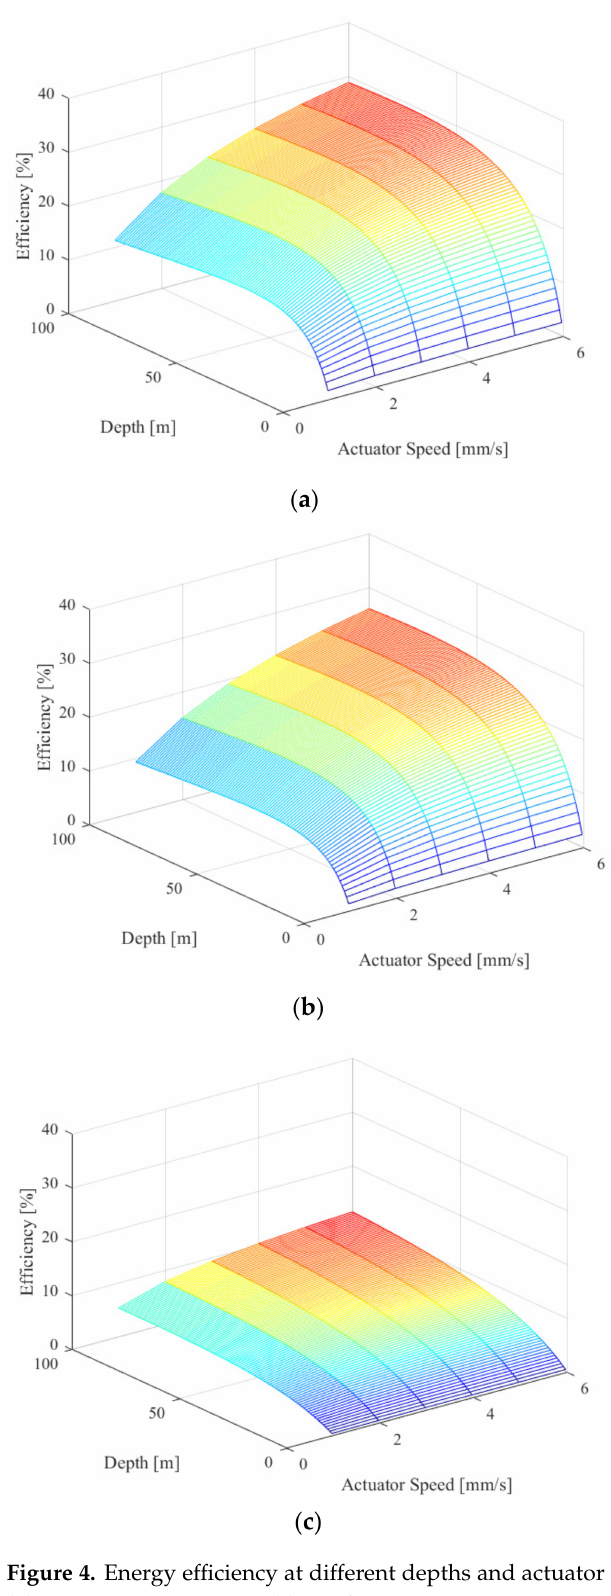
Figure 4. Energy efficiency at different depths and actuator speeds for: ( a ) Warner Linear 24VDC; ( b ) Warner Linear 12VDC; ( c )